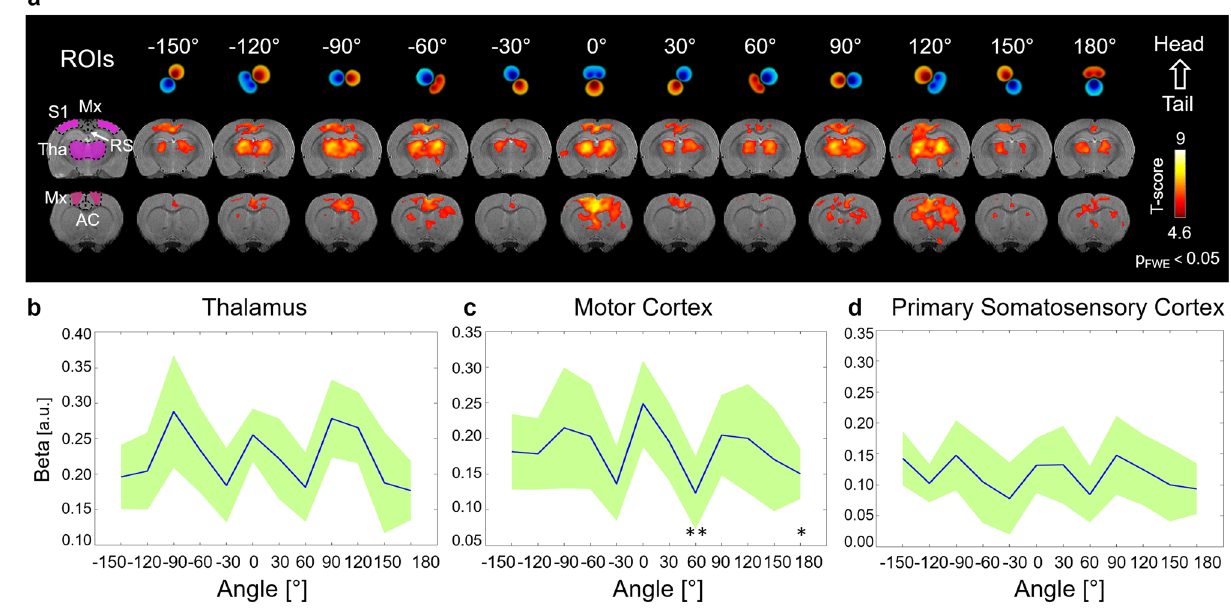
Figure 3. Group level responses to OS-ESCS with 3-channel electrodes. ( a ) Group level maps of the main effects (t-maps) in two different brain slices. Maps were obtained by the one-way within subject ANOVA model (p < 0.05 FWE corrected, n = 11). ROI-averaged beta values in the thalamus ( b ), in the motor cortex ( c ) and in the primary somatosensory cortex ( d ) in response to different stimulation angles. Blue line indicates mean while green shading indicates the standard deviation. Holm’s-corrected *p < 0.05, **p < 0.01 (linear mixed model comparisons vs 0°). S1 primary somatosensory cortex, Mx motor cortex (including primary and secondary